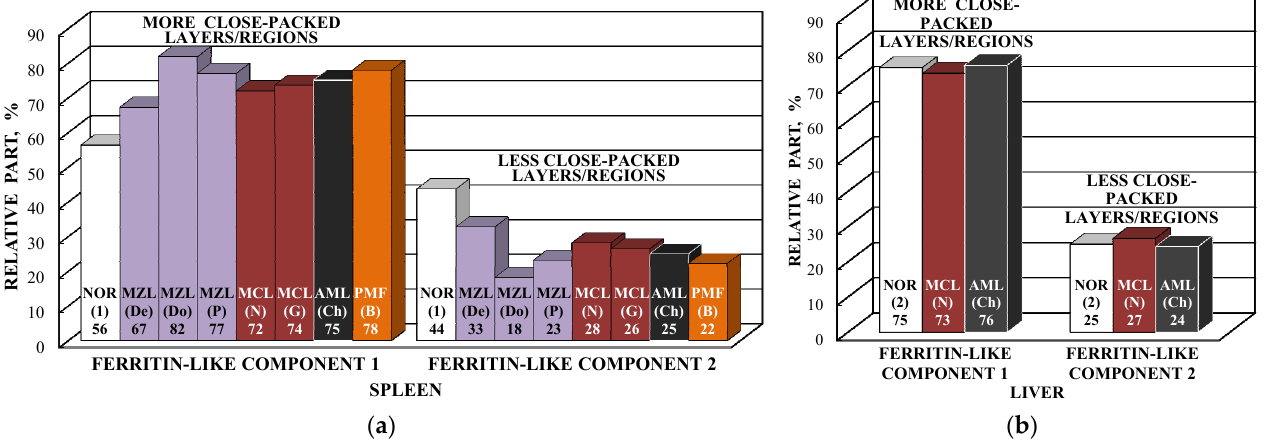
Figure 14. Rough estimation of more and less close‑packed layers/regions in the nanosized ferritin‑like iron cores in spleen ( a ) and liver ( b ) tissues from healthy human and patients with hematological malignancies based on the relative areas of ferritin‑like components 1 and 2 in the corresponding Mössbauer spectra. Adapted from Ref. [59] with permission from Springer Nature: Cell Biochemistry and Biophysics, “The iron state in spleen and liver tissues from patients with hematological malignancies studied using magnetization measurements and Mössbauer spectroscopy”,